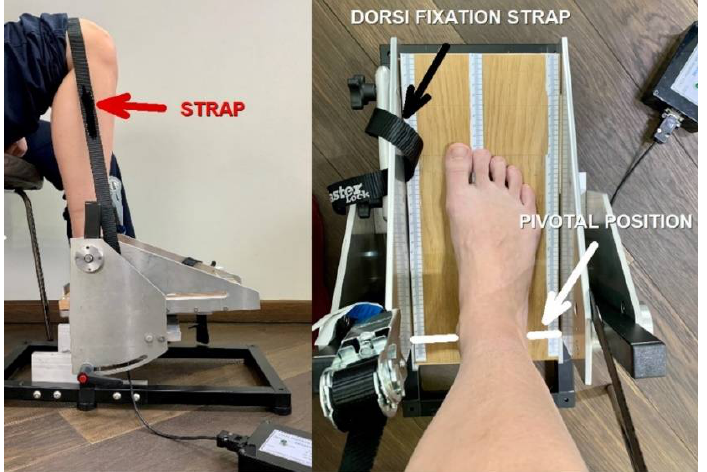
Figure 3. The participant’s position on the chair, fixation of straps ( left ) and foot position on the plate, with ankle malleoli axis above the pivotal line mark ( right ).